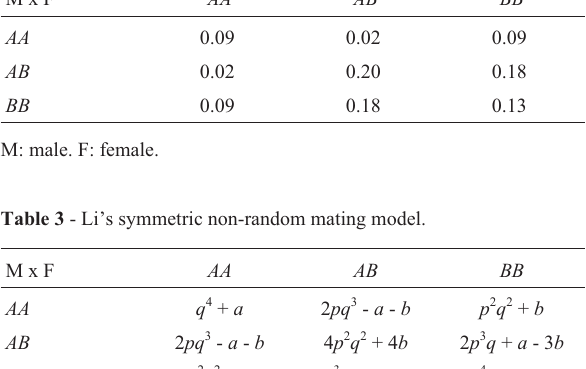
Table2 -Matingschemewith q =0.4, F =1/6, G =0, s =0.05and t =0.02. M x F